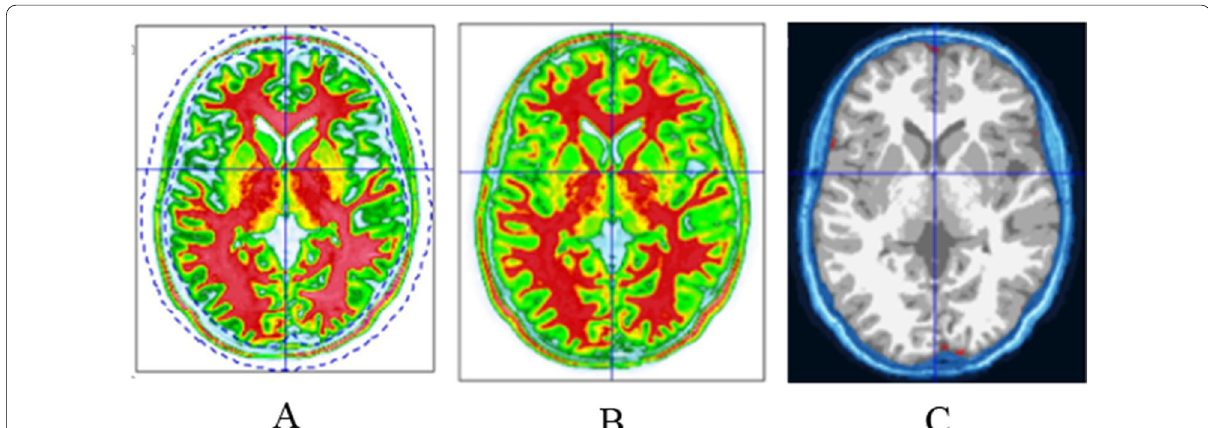
Fig. 2 Pre‑processing steps in CAT12 toolbox. A Original image. B Image after intensity normalization. C Segmented image